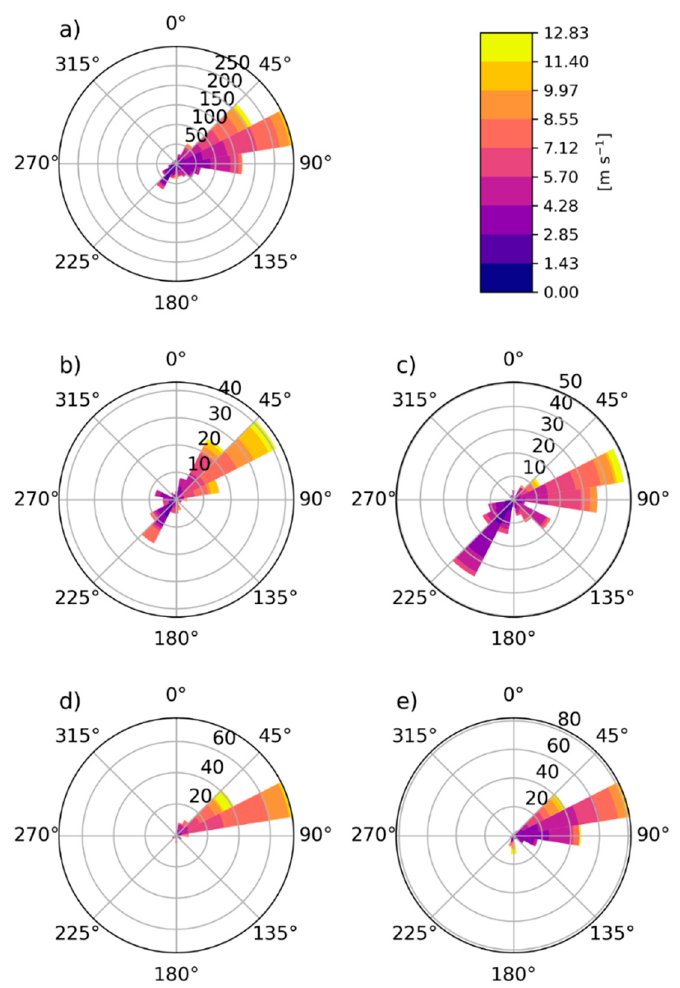
Figure 7. Windroses: ( a ) total time period; ( b ) first half, day; ( c ) first half, night; ( d ) second half, day; ( e ) second half, night.